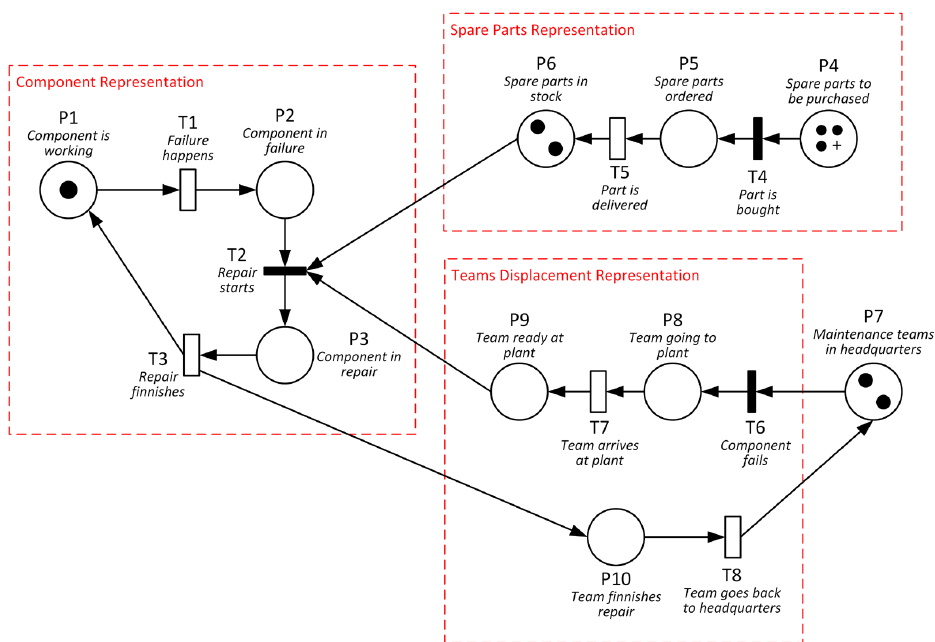
Figure 2. The Generalized Stochastic Petri Nets (GSPN) proposed structures.